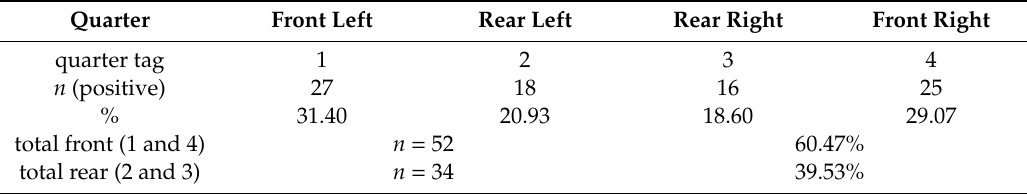
Table 2. Number of total microbiological positive udder